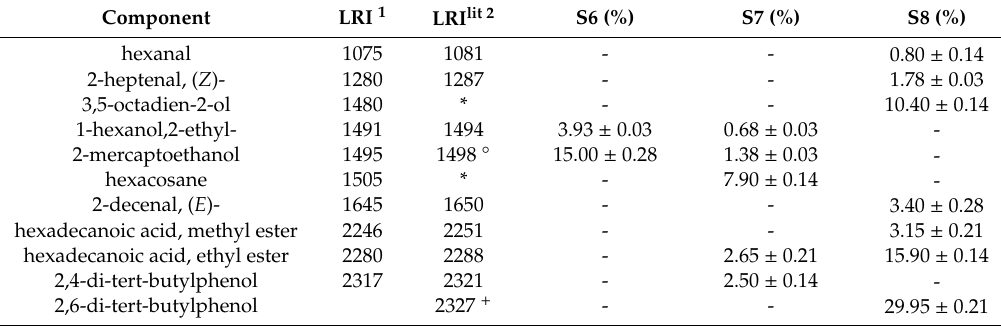
Table 2. Chemical composition (%) of S6, S7, and S8 samples obtained by thin-layer chromatography separation from Papaver rhoeas ovule ethanol